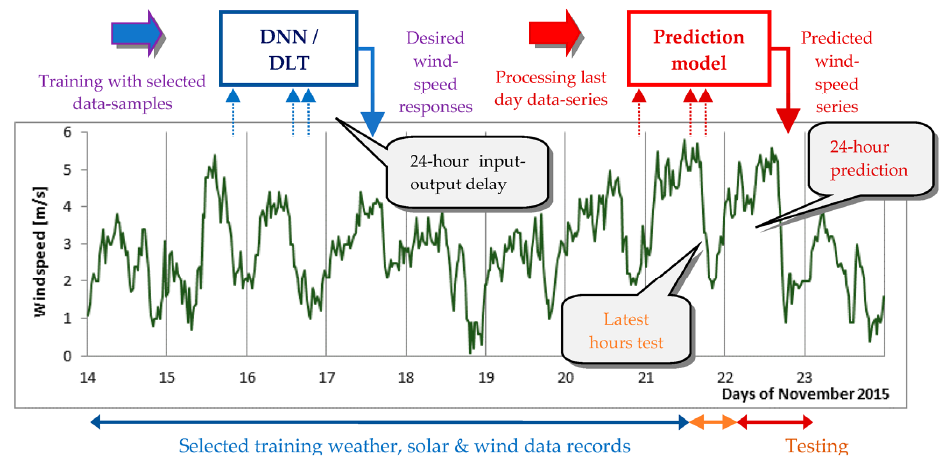
Figure 2. Learning, testing, prediction practice in daily solar and wind parameter forecasting.